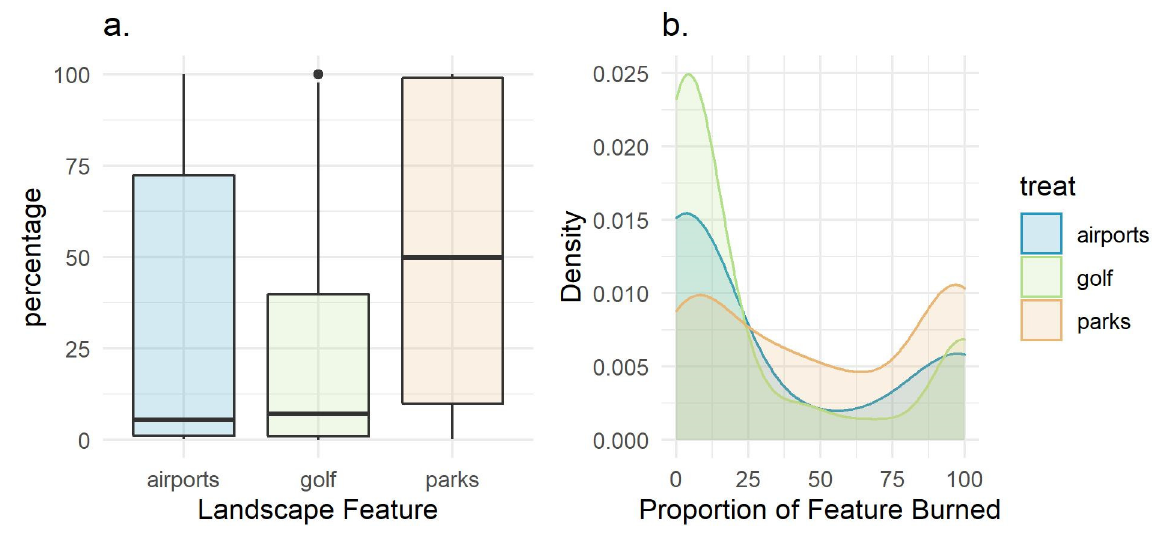
Figure 5. Boxplot ( a ) and smoothed density estimate ( b ) distribution of proportion of land burned of the golf, airport, or park polygons.